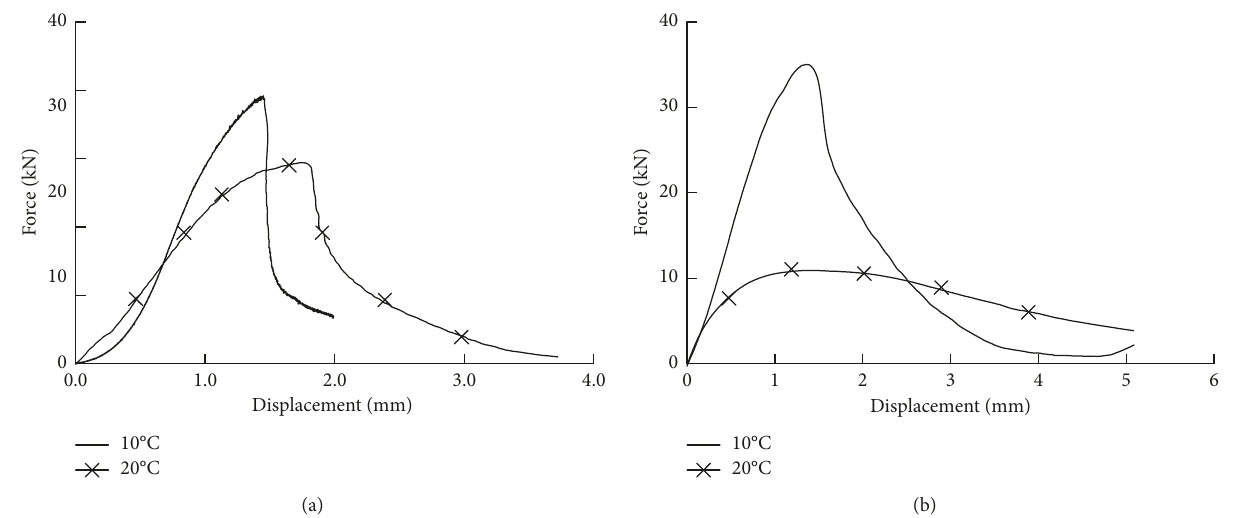
Figure 9: Splitting test results of AC-20. Load-displacement curve: (a) − 10 ° C and 0 ° C and (b) 10 ° C and 20 ° C